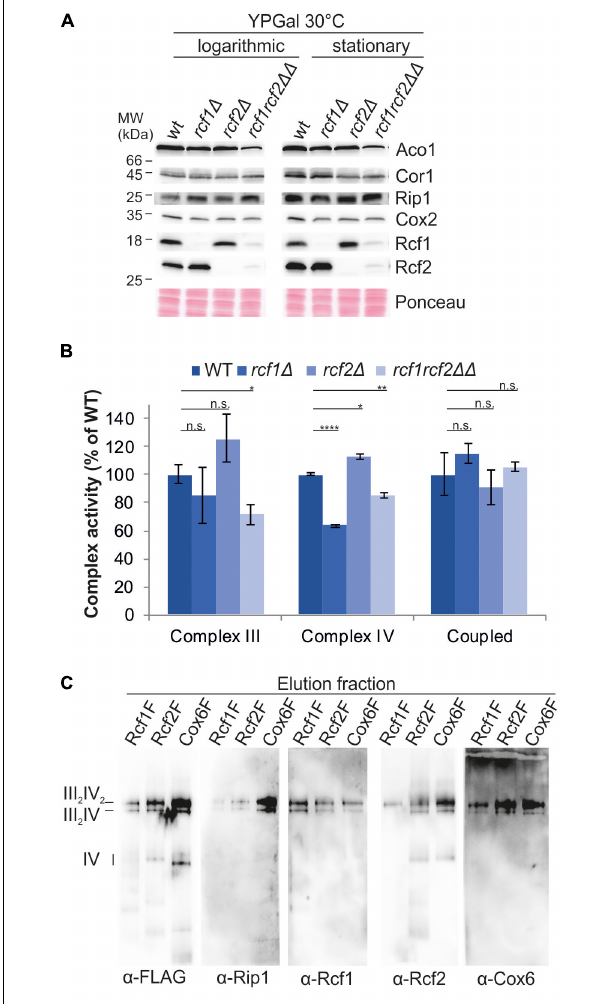
FIGURE 2 | Rcf1 and Rcf2 affect cytochrome c oxidase activity without affecting its subunit amount. (A) Steady state protein levels of cells grown to logarithmic or stationary phase showed that the loss of Rcf1 or Rcf2 did not change the protein levels of bc 1 complex (Cor1, Rip1) or cytochrome c oxidase subunits (Cox2). As control aconitase (Aco1) levels and total protein amount (ponceau) were used. (B) Cytochrome c reduction measurements showed that only in absence of both Rcf1 and Rcf2 bc 1 complex (Complex III) activity was decreased. Oxygen consumption measurements demonstrated that cytochrome c oxidase (Complex IV) activity was decreased upon loss of either Rcf1 or both Rcf1 and Rcf2 while loss of Rcf2 alone led to an increase in activity. The coupled activity of the supercomplexes (Coupled) was not affected by the absence of either Rcf1 or Rcf2 [the standard errors were calculated from a sample size of n = 3 (complex III and complex IV) or n = 4 (coupled)]. n.s., P > 0.05; ∗ P ≤ 0.05; ∗∗ P ≤ 0.01; ∗∗∗ P ≤ 0.001; ∗∗∗∗ P ≤ 0.0001. (C) Supercomplexes were purified from mitochondria (cells grown YPG, 30 ◦ C, to logarithmic phase) via a FLAG-tag on Rcf1 (Rcf1F), Rcf2 (Rcf2F) or the cytochrome c oxidase subunit Cox6 (Cox6F). All three proteins co-purified supercomplexes but to different amounts.